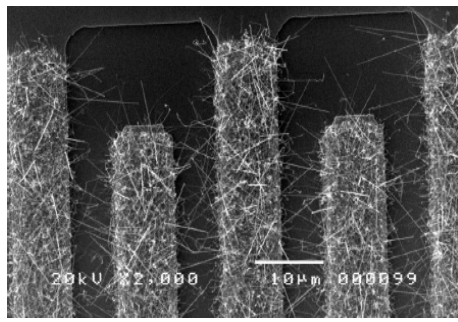
Figure 2. SEM top view of a VLS SiNWs based resistor used as bacteria sensor.